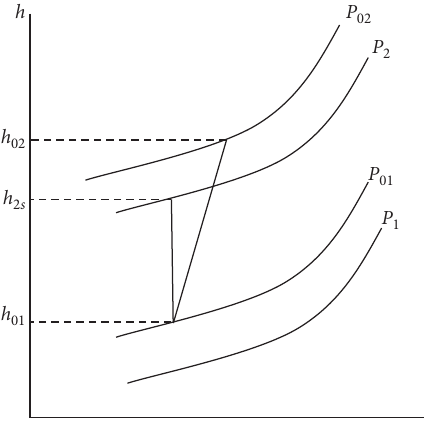
Figure 4: Ideal and realistic compression processes inside the